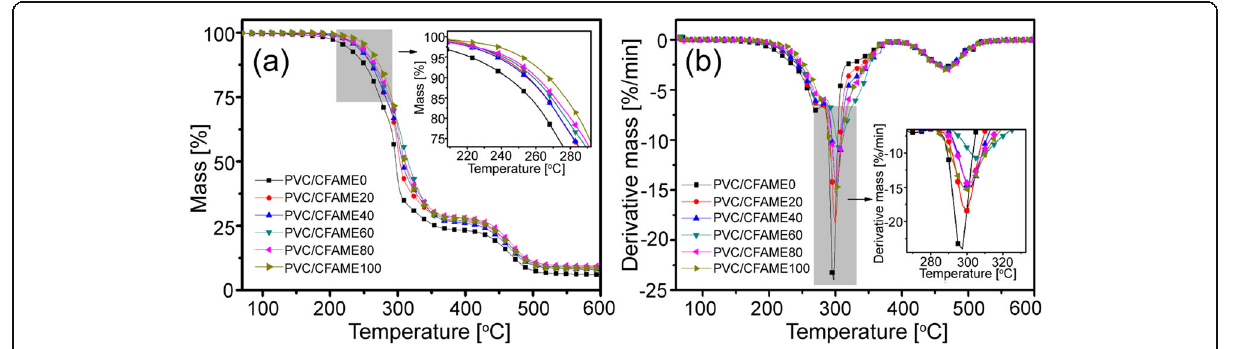
Fig. 6 a TGA and b DTG curves of PVC/CFAME x coatings